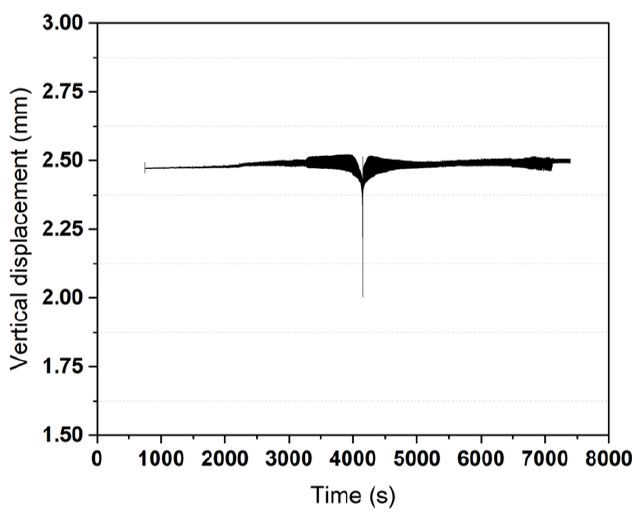
Figure 5. Vertical oscillations of the PM. From Equation (4), 0.003 mW and 0.0016 mW of power is dissipated above and below resonance, respectively. The below-resonance power loss is consistent with the hysteresis loss as the total loss is dominated by hysteresis loss in that region. The larger power loss above resonance can be caused by additional radial components of magnetic